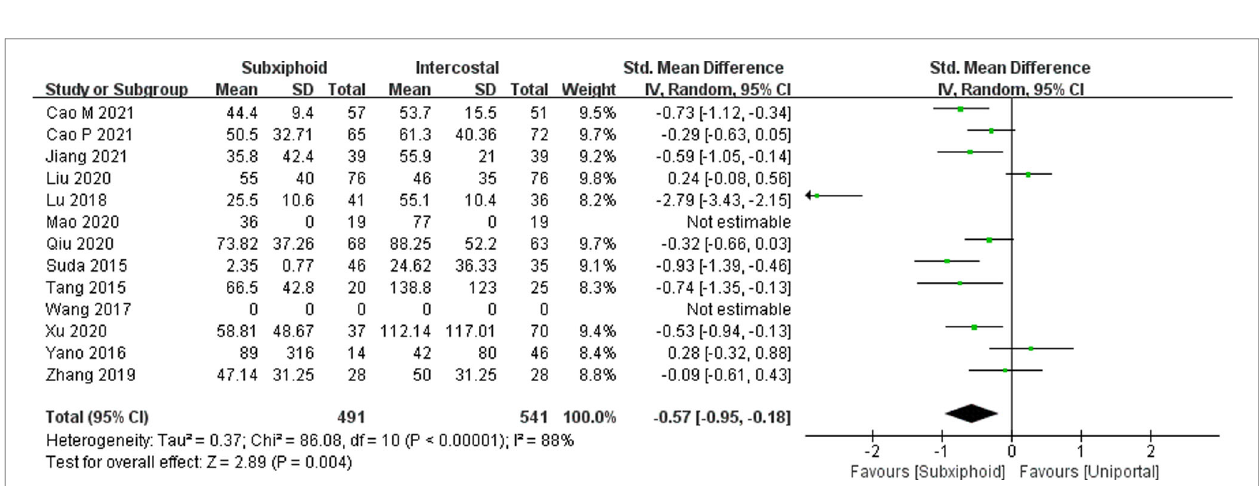
Frontiers in Surgery |